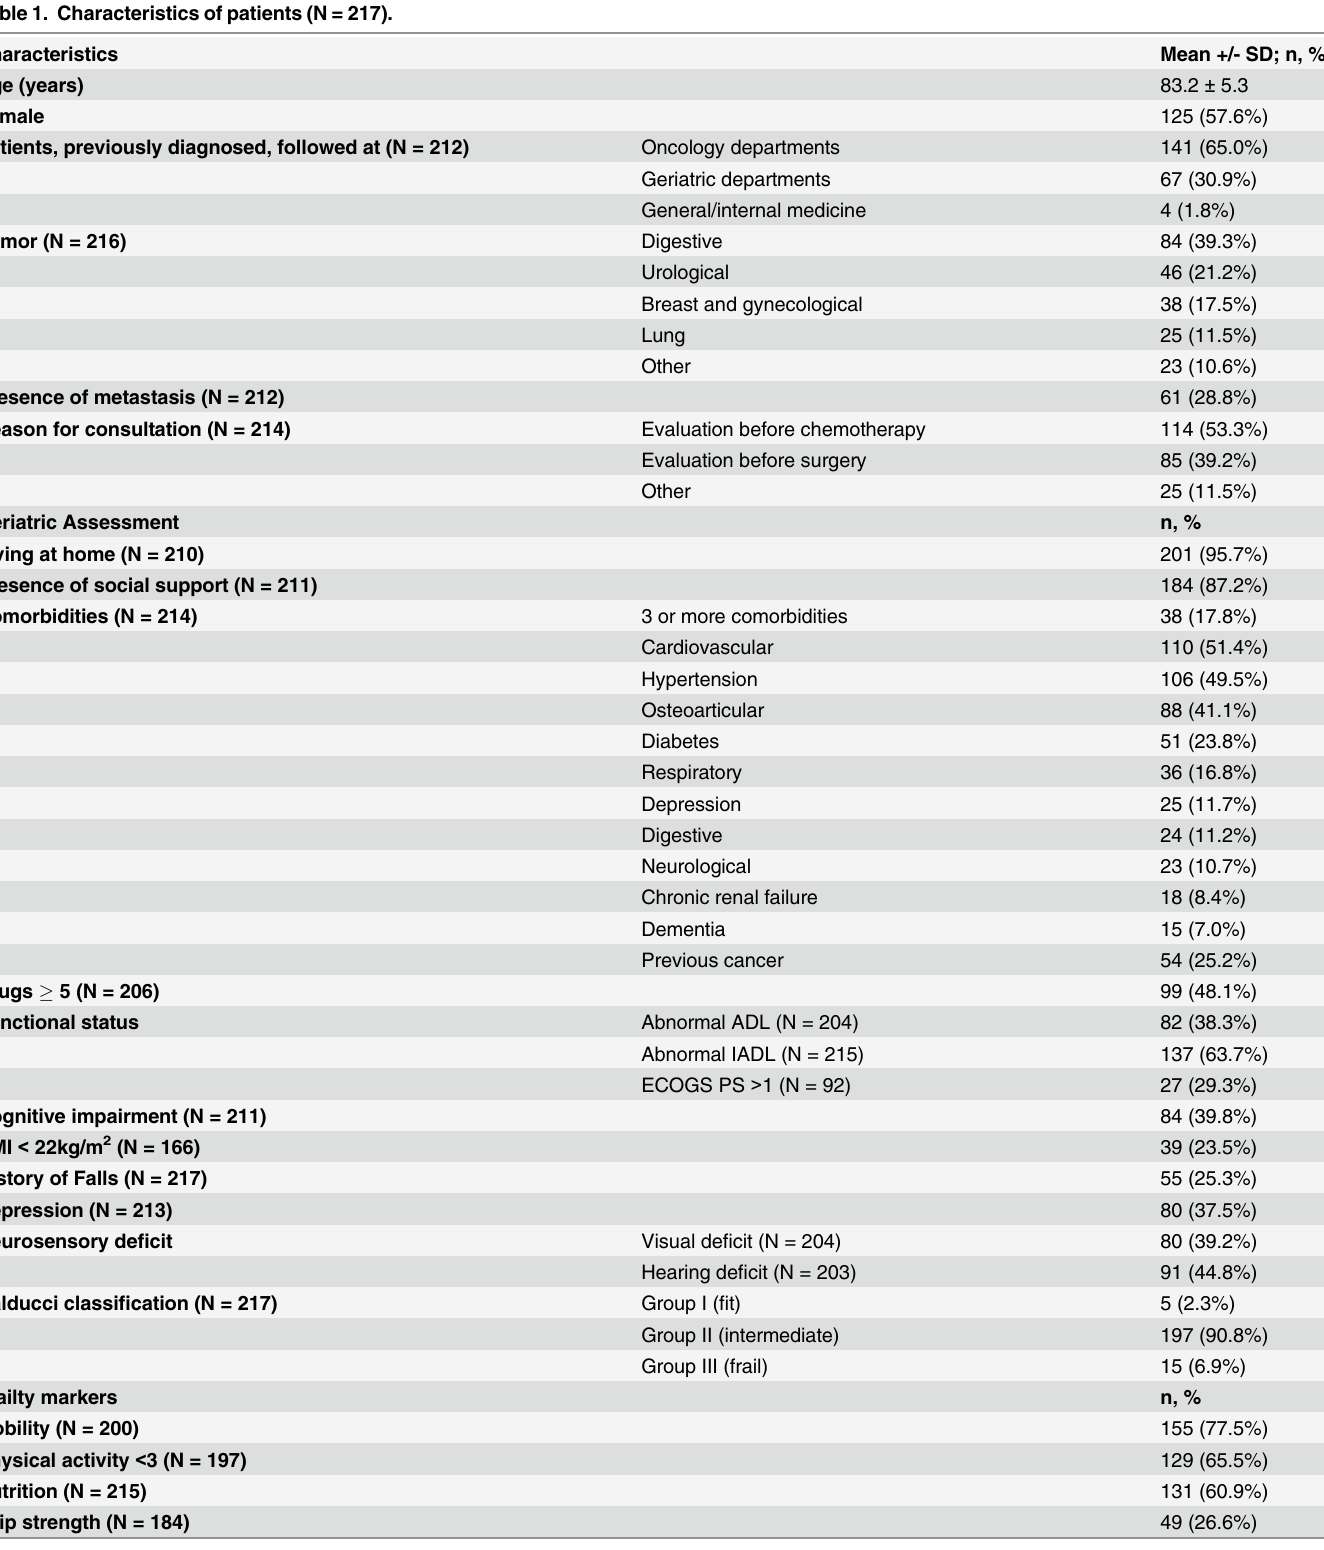
Table 1. Characteristics of patients (N =